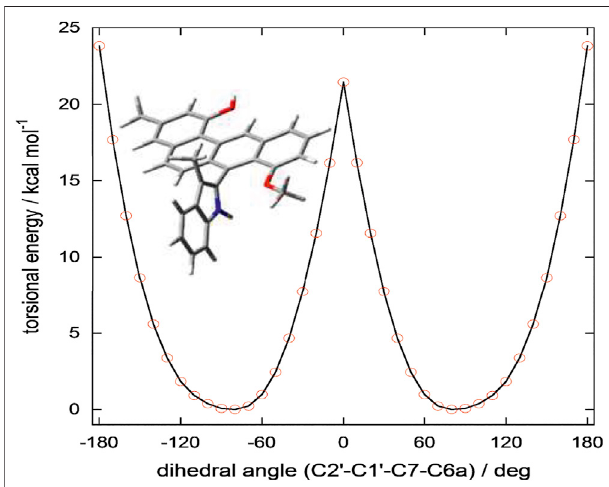
FIGURE 5 | Torsional energy scan of a simpli fi ed model of 3 run at ω B97X-D/6-31+G(d) level in vacuo. In the truncated model trunc-3, the substituent at C2 ’ in 3 (CH 2 CH 2 NHCOCH 3 ) was replaced by a methyl group (see Figure). The substituent CH 2 CH 2 NHCOCH 3 iscapable ofstabilizing the energy minima by intramolecular hydrogen bonding (see Supplementary Figure S1 ); on the contrary, it hardly affects the energy of the transition state because it folds away from the benz[ a ]anthracene ring. Therefore, the energy barrier of trunc-3 offers a lower estimate of the racemization barrier in 3. The plot was obtained by running two independent torsional energy scans varying the C2 ’ -C1 ’ -C7-C6a dihedral angle in steps of 10 ° and considering for each value of the dihedral angle the lowest energy